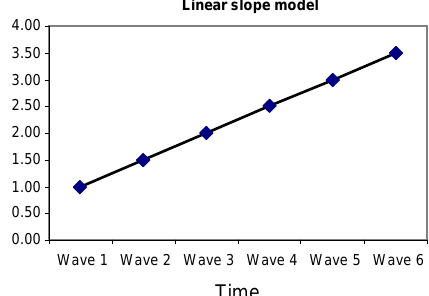
FIGURE 1. A hypothesized linear slope model.